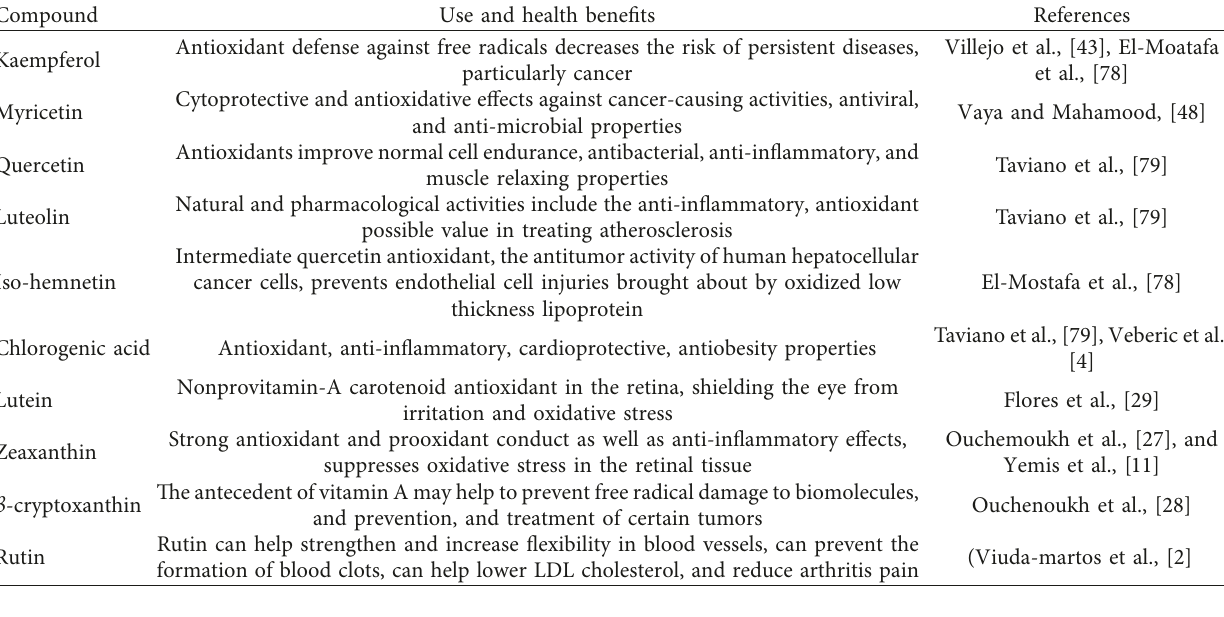
Table 7: Health benefits of bioactive compounds present in Ficus species.